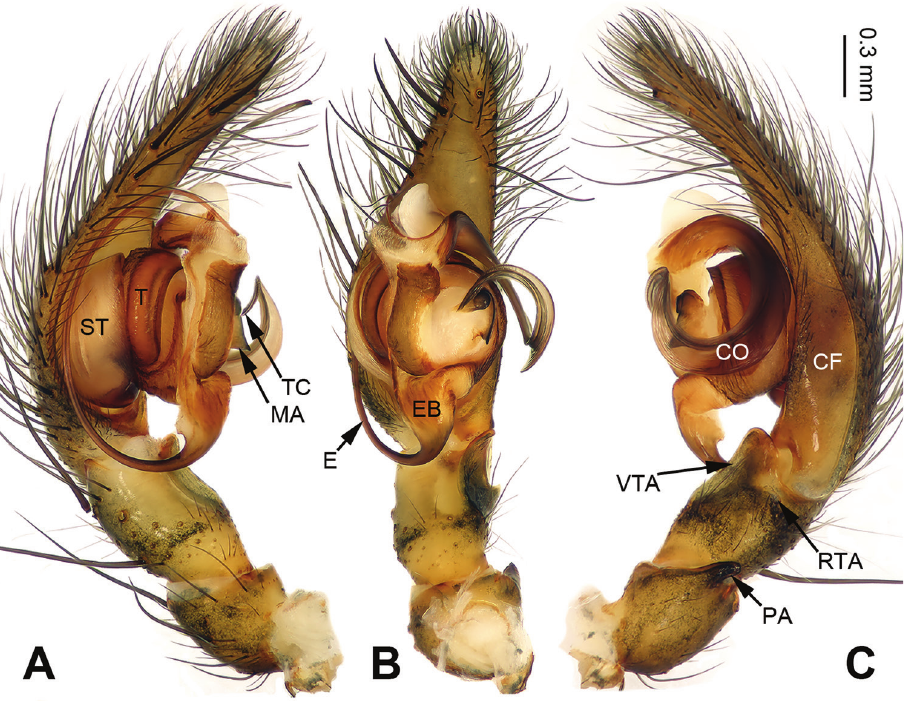
Figure 5. Palp of Pireneitega lushuiensis sp. n., male holotype. A Prolateral view B Ventral view C Retro- lateral view. Scale bar: equal for A, B, C